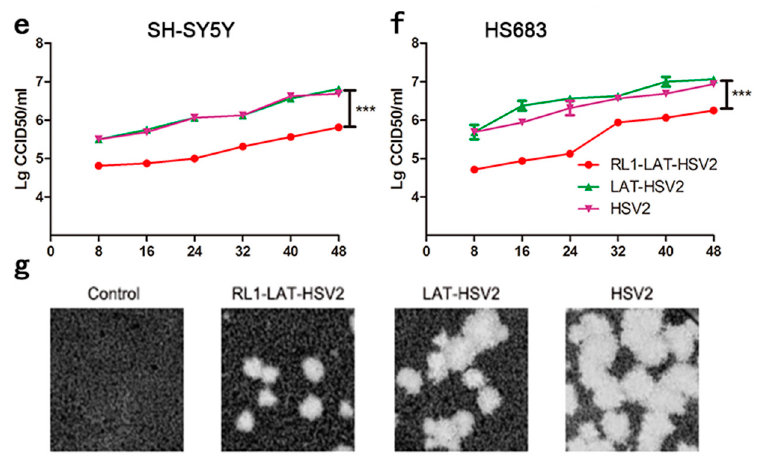
Figure 1. Modification of the RL1 gene and LAT gene and identification of the LAT- HSV-2 and RL1-LAT- HSV-2 mutant strains. ( a ) The design and construction of the LAT- HSV-2 mutant strain, which contains a LAT gene with a 102 nt deletion generated by CRISPR / Cas 9 modification. ( b ) The design and construction of the RL1-LAT- HSV-2 mutant strain, which contains a LAT gene with a 190 nt deletion and an RL1 gene with a 240 nt deletion generated by CRISPR / Cas 9 modification. ( c ) The LAT gene was identified in the mutant ( LAT- HSV-2) and wild-type (HSV-2) strains by PCR. ( d ) The LAT gene and RL1 gene were identified in the mutant ( RL1-LAT- HSV-2) and wild-type (HSV-2) strains by PCR. The proliferation of the mutant ( RL1-LAT- HSV-2 and LAT- HSV-2) and wild-type (HSV-2) strains in human neuroblastoma (SH-SY5Y) cells. ( e ) The proliferation of the mutant ( RL1-LAT- HSV-2 and LAT- HSV-2) and wild-type (HSV-2) strains in human neuroblastoma cell line (SH-SY5Y) cells. ( f ) The proliferation of the mutant ( RL1-LAT- HSV-2 and LAT- HSV-2) and wild-type (HSV-2) strains in human glioma (HS683) cells. The data are shown as the mean ± SD. Statistical significance was measured by the log-rank test. *** p < 0.001. ( g ) Plaque phenotypes of the mutant ( RL1-LAT- HSV-2 and LAT- HSV-2) and wild-type (HSV-2) strains in Vero cells stained using crystal violet. Magnification: 10 ×